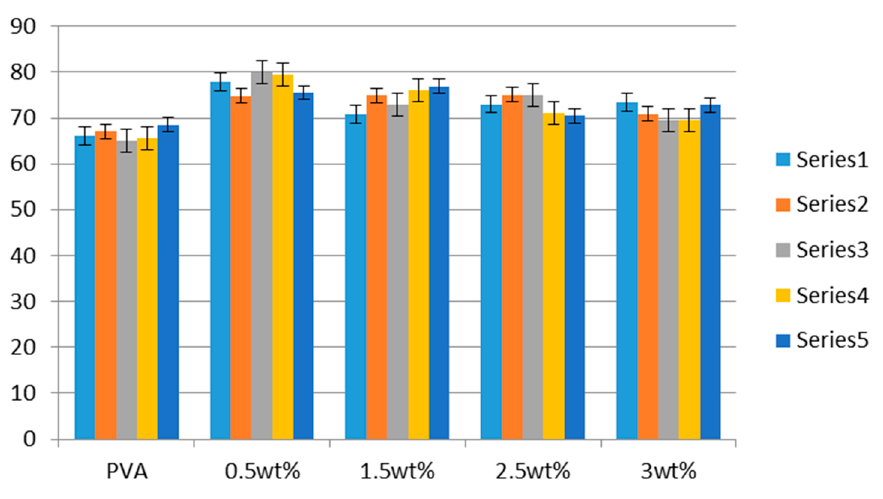
Figure 7. Hydrophilic behavior of all resultant samples.